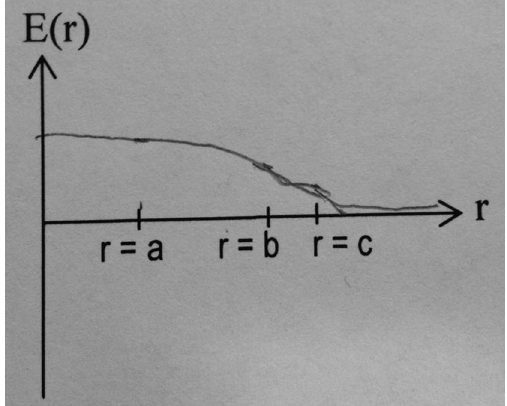
FIG. 5. Electric field plotted by Charles (an interviewed student).